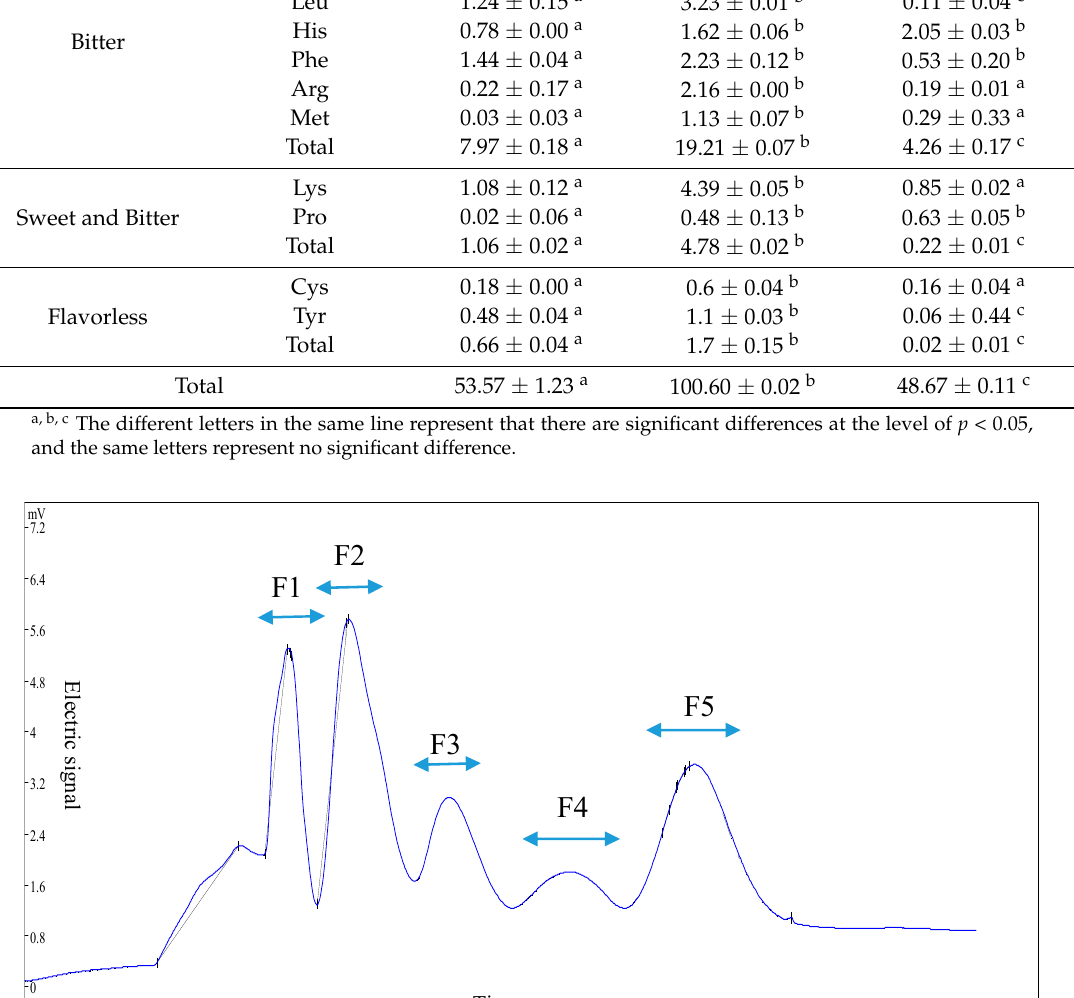
Table 2. Amino acids in peptides of different fractions from ultrafiltration.